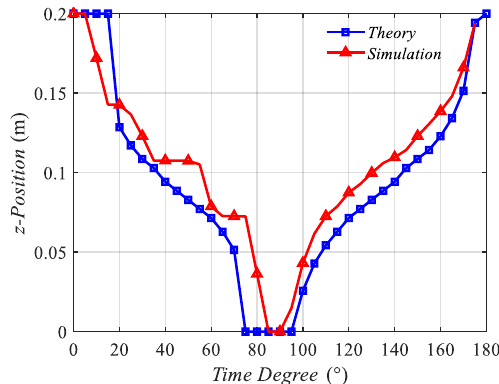
Figure 17. Verification of the theoretical analysis.